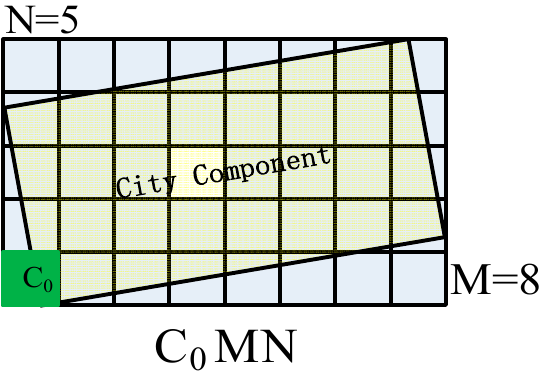
Figure 2. Identification code based on the discrete global grid system.